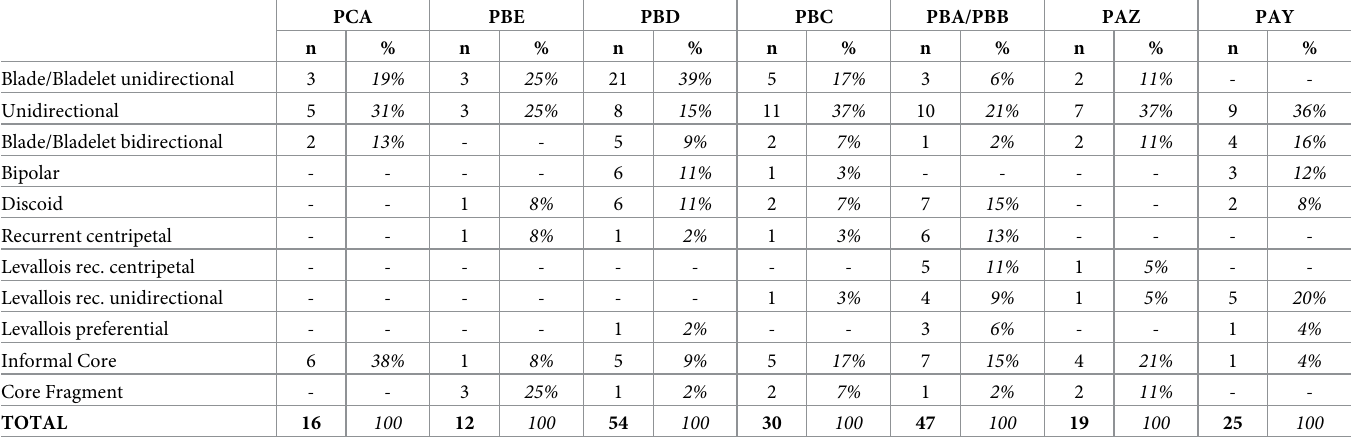
Table 2. Core reduction methods identified in the sequence of KDS.